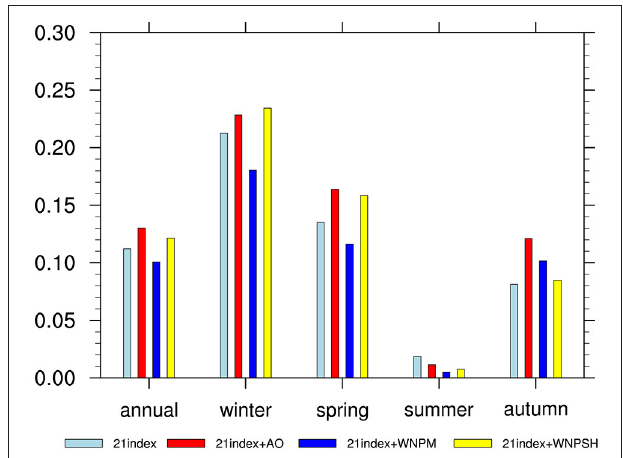
FIGURE 6 | The prediction skill of annual average, winter season, spring season, summer, and autumn season of 2011–2016 for 21 index model (light blue bar), 21 index + AO model (red bar), 21 index + WNPM model (blue bar), and 21 index + WNPSH model (yellow